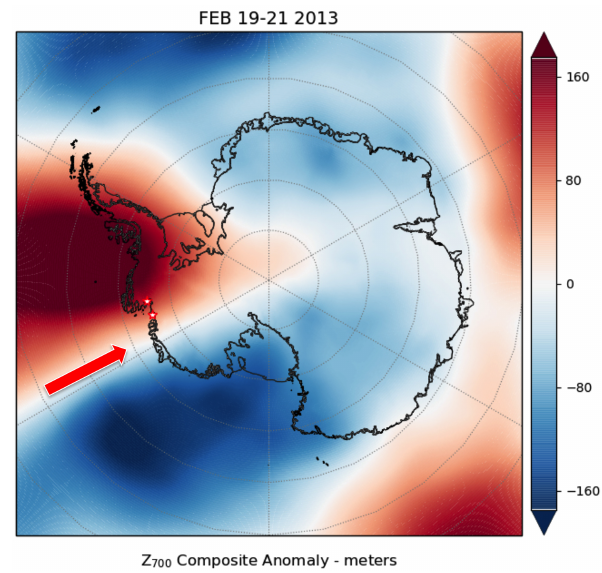
Figure 10. Composite anomaly of ERA5 700hPa geopotential height for 19–21 February 2013. The red stars depict the locations of Pine Island and Thwaites glaciers. The red arrow depicts the di- rection of 700hPa winds relevant to the case